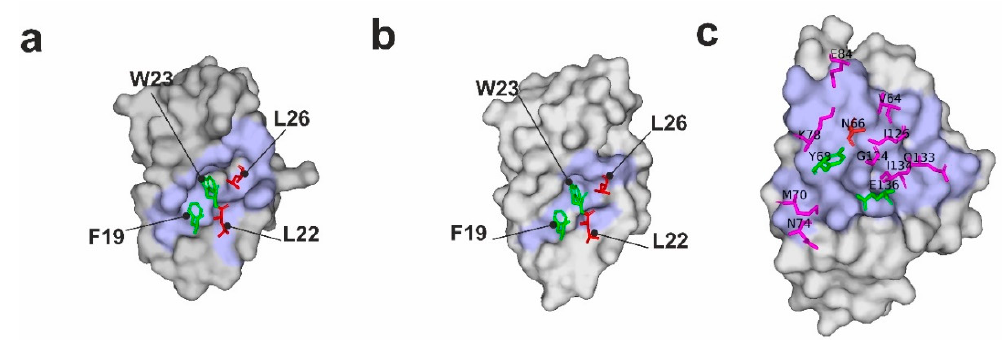
Figure 1. Visualization of the p53 / Mdm2 ( a ), p53 / MdmX ( b ), and PD-1 / PD-L1 ( c ) complexes (PDB IDs:1YCR, 3DAB, and 4ZQK, respectively). The surface representation of Mdm2, MdmX, and PD-L1 is shown in gray with their interfaces with p53 and PD-1 in pale blue. For better visibility of the interfaces, p53 peptide is fully depicted as a cartoon, while only PD-1 residues crucial for interactions are shown. Interacting residues from p53 and PD-1 are shown as sticks with purple ones interacting with binding partners but not being essential for the interactions, green being residues whose mutation abolishes the interactions, and red being amino acids that were mutated within this manuscript consideration.